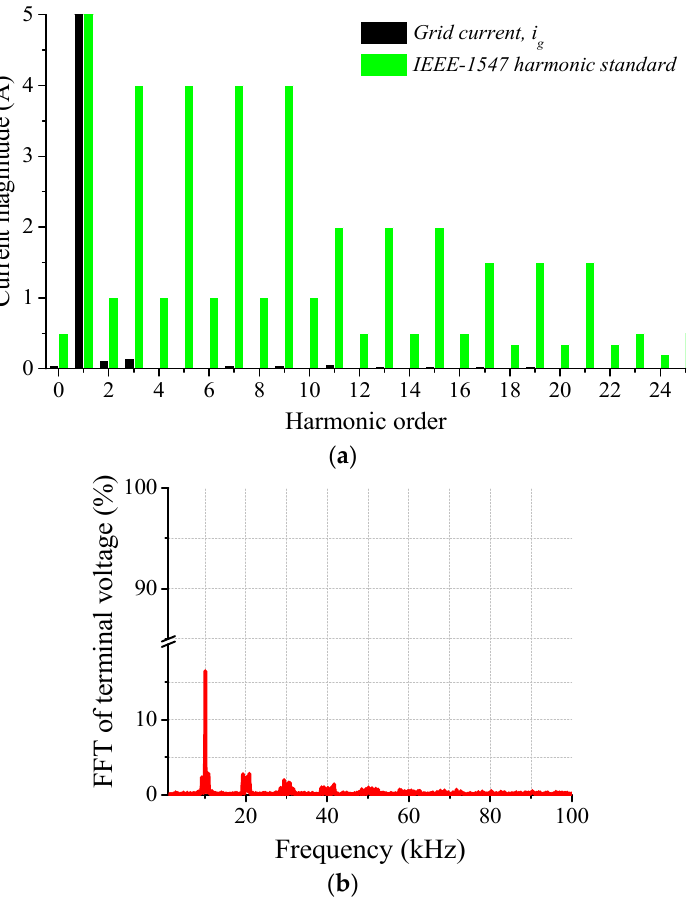
Figure 11. FFT analysis of inverter output voltage and grid injected current; ( a ) grid current, and ( b ) inverter voltage.